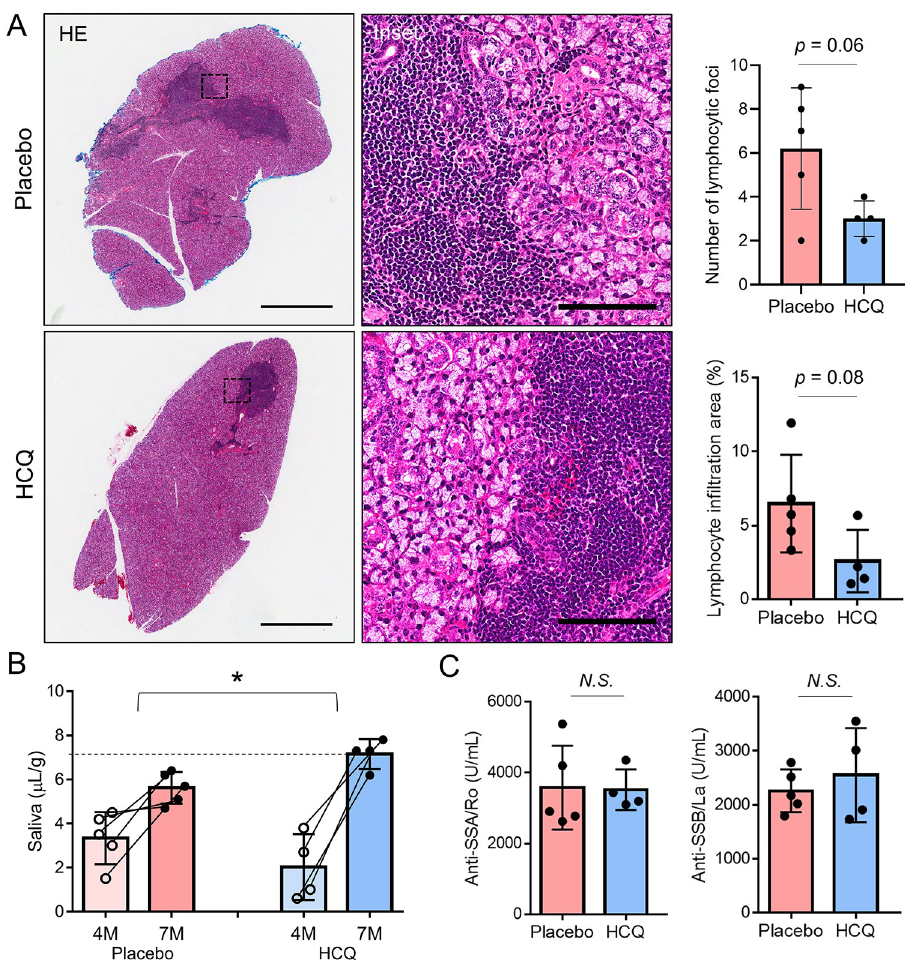
Fig 4. Hydroxychloroquine treatment ameliorates LAMP3-associated sialadenitis in vivo . Submandibular glands of C57BL/6 mice were instilled with AAV2-LAMP3. After 4 months, mice were given weekly intraperitoneal injections of 60 mg/kg HCQ ( n = 4) or placebo ( n = 5) for 3 months. ( A ) Representative submandibular gland tissue sections showing hematoxylin & eosin (HE) staining. Scale bars = 1 mm (inset: 100 μ m). Bar charts shows the number of lymphocytic foci and the average size of lymphocytic infiltration areas in both the submandibular glands of each mouse. ( B ) Graph showing pilocarpine-stimulated salivary flow rate per body weight in 20 minutes. The dashed line indicates a reference level of salivary flow rate derived from control mice (instilled with AAV2-GFP). ( C ) Bar charts showing serum anti-Ro/SSA or anti-La/SSB antibody levels. Values shown are mean ± SD. � P < 0.05, N.S. = not significant (Student’s t